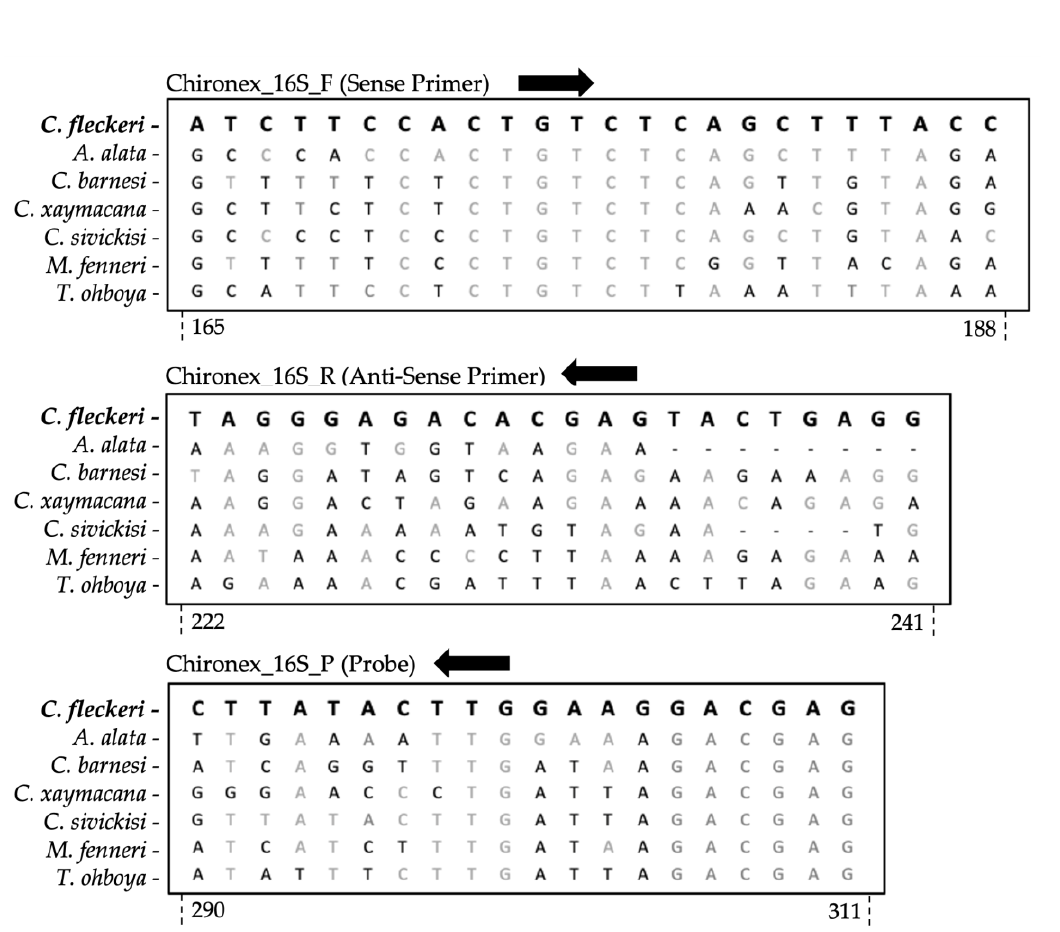
Figure 3. Alignment highlighting base pair similarities (grey) and differences (black) between the Chironex fleckeri eDNA identifiers and sympatric jellyfish species. The anti-sense primer is illustrated as the reverse complement of the sequence. ( Chironex fleckeri ; OP877024, Copula sivickisi ; OP877032, Carukia barnesi ; OP877033, Alatina alata ; OP877035, Carybdea xaymacana ; OP877034, Tamoya ohboya ; HQ824528). Base pair start and end position of each identifier on the consensus sequences is indi-